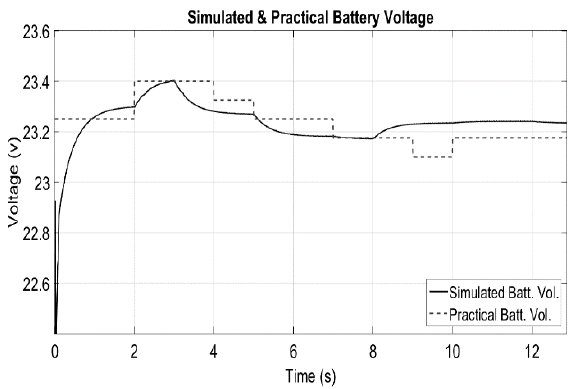
Figure 8. Comparison between simulated and practical battery voltages.